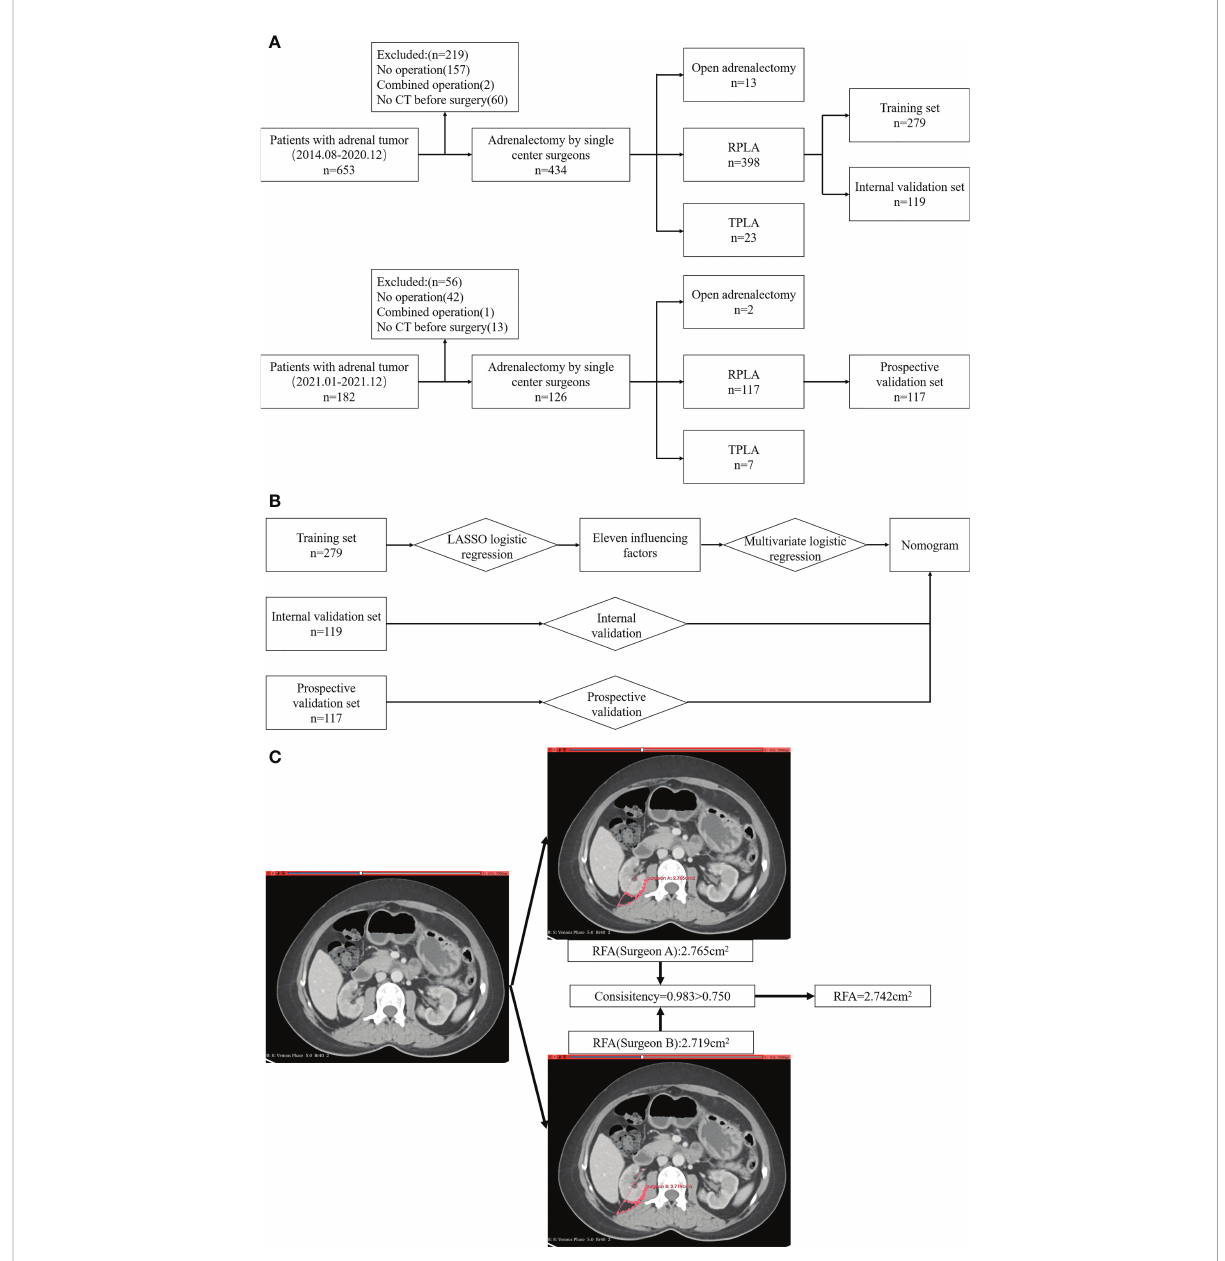
FIGURE 1 Study fl owchart. (A) Inclusion and exclusion process; (B) Analysis and veri fi cation process; (C) Drawing of ROI and calculation of